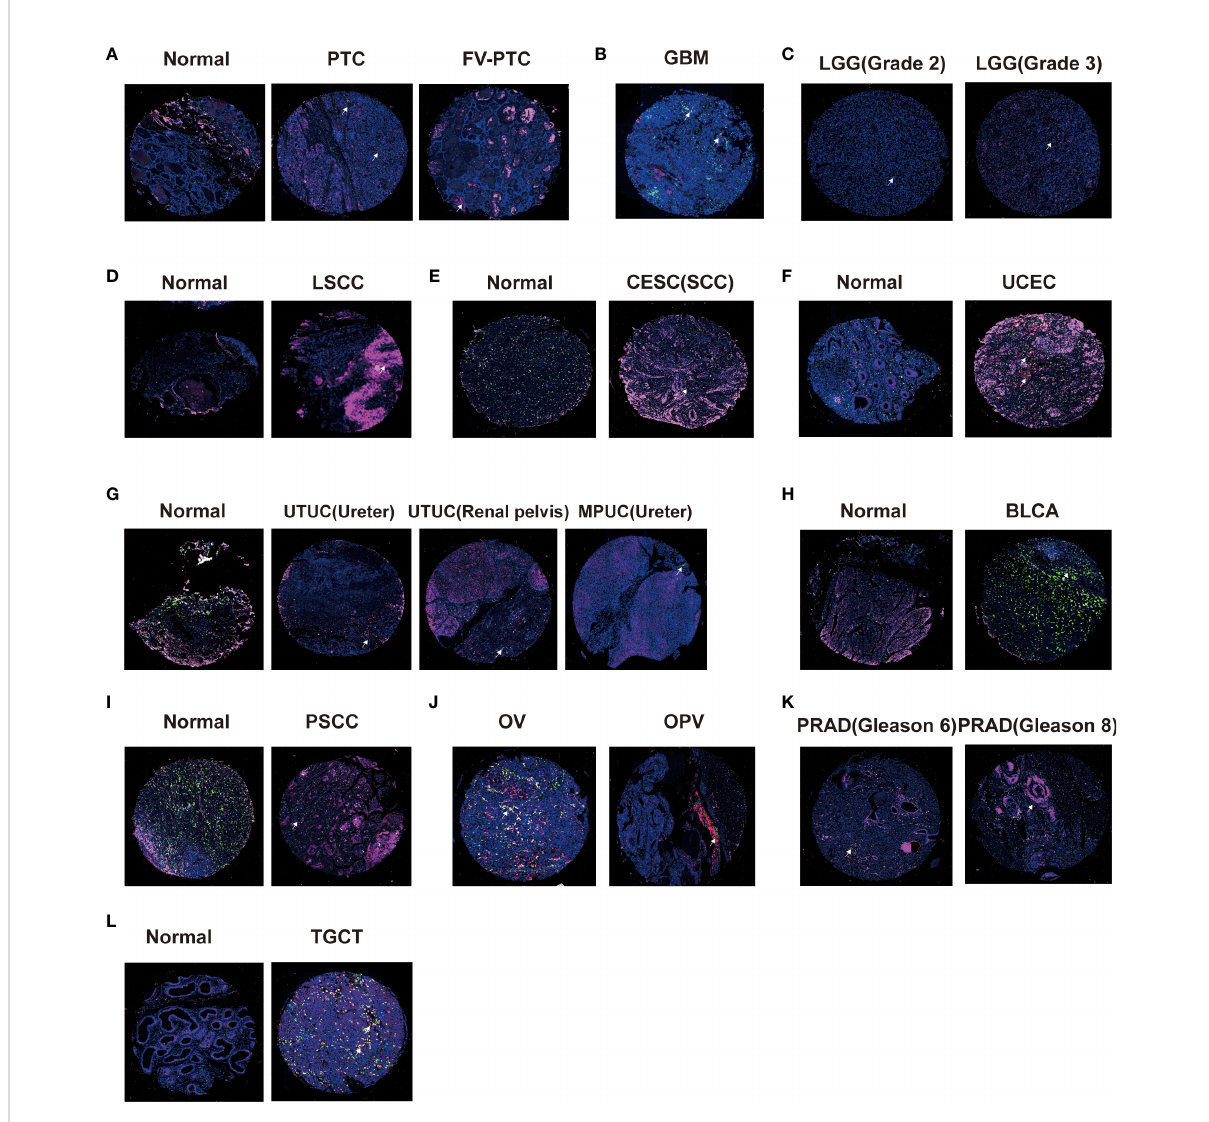
FIGURE 8 Triple immuno fl uorescence method was used to analyze the correlation between CD161 expression and T cells and macrophages. The expression levels of CD161 on T cells and macrophages in PTC and FV-PTC (A) , GBM (B) , LGG (C) , LSCC (D) , CESC (E) , UCEC (F) , UTUC and MPUC (G) , BLCA (H) , PSCC (I) , OV and OPV (J) , PRAD (K) , and TGCT (L)